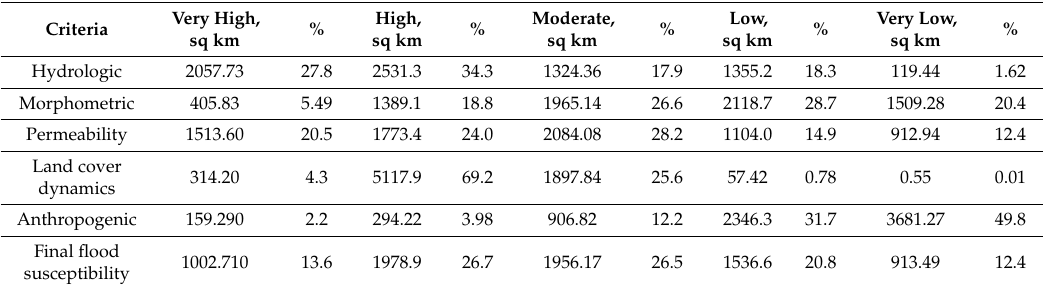
Table 5. Area coverage of flood susceptibility classes.